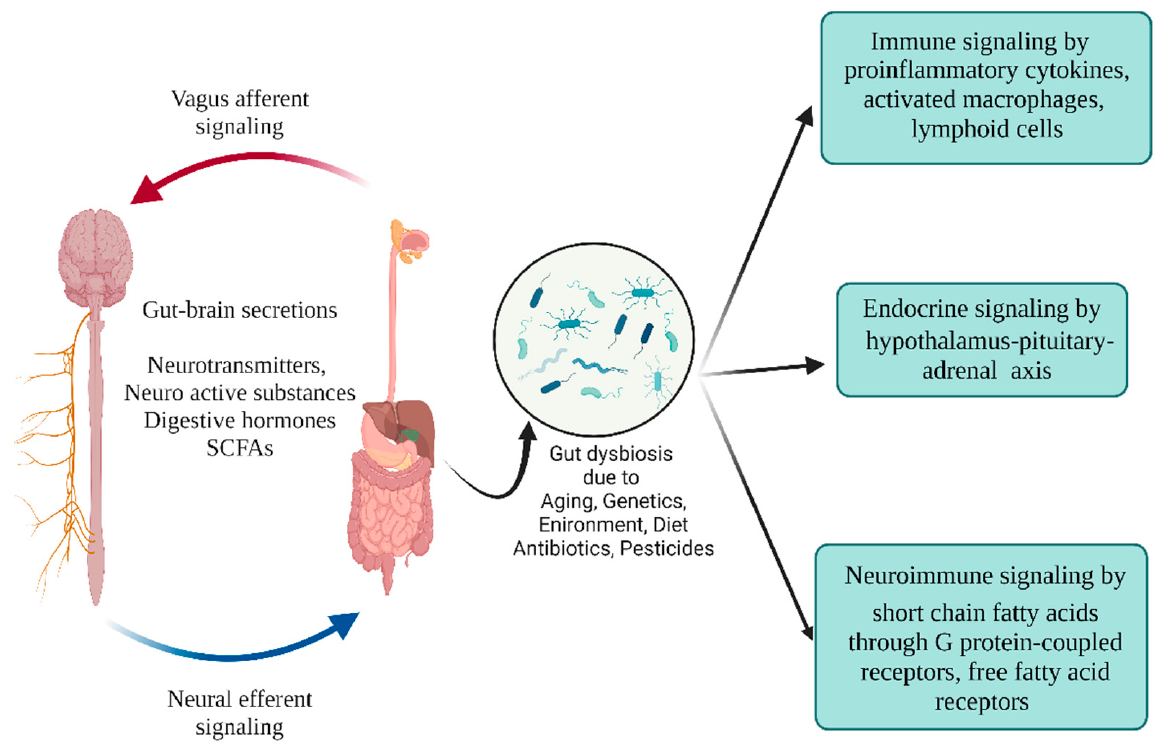
Figure 5. Schematic illustration of endocrine, immune, and neuroimmune signaling pathways. Gut microbes help maintain intestinal integrity by balancing the microbial products, neurotransmitters, and SCFAs across the enteric and immune systems. Microbial dysbiosis triggers activated immune cells, macrophages, dendritic cells, and pro-inflammatory cytokines. (Figure created using BioRender.com) .